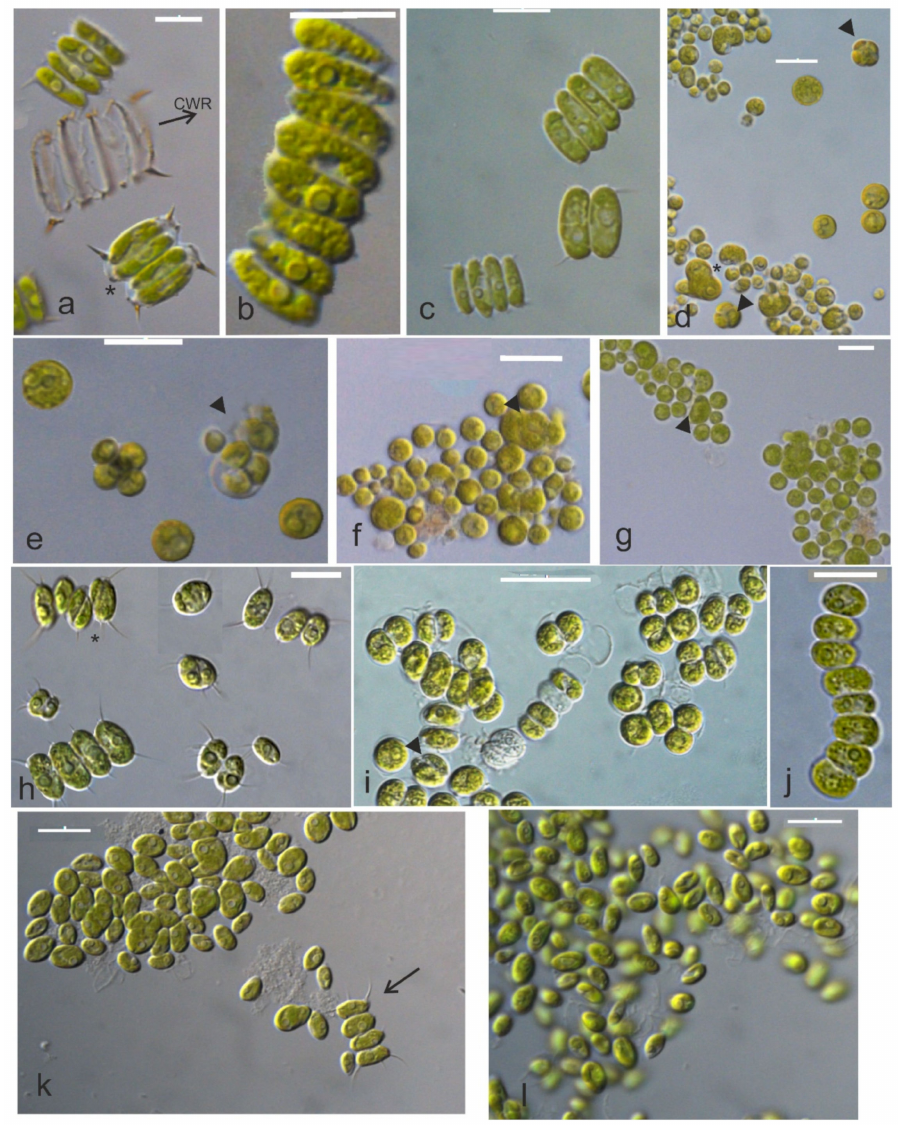
Figure 5. Light micrographs of strains Desmodesmus sp. TAU-MAC 0910 ( a , b ) and 1010 ( c ), Desmod- esmus sp. 1817 ( d ), 2017 ( e , f ) and 2617 ( g ), Desmodesmus subspicatus 0415 ( h ), Desmodesmus multi- variabilis 1917 ( i ) and 2517 ( j ), Desmodesmus abundans 2117 ( k ) and 2717 ( l ); ( a ): a mature four-celled coenobium, cell wall ornaments (observable from cell wall residues, CWR) and a cell division of mother cell into two daughter cells (asterisk). ( b ): an eight-celled coenobium. ( c ): mature two- and four-celled coenobia. ( d ): young and mature cells, autosporangia (arrowheads), and a cell division of the mother cell into two daughter cells (asterisk). ( e , f ): young and mature cells and aplanosporia (arrowhead). ( g ): young and mature solitary cells and aplanosporia (arrowhead). ( h ): coenobia with numerous spines and a cell division of mother cell into two daughter cells (asterisk). ( i ): solitary cells and two-celled coenobia and aplanosporia (arrowhead). ( j ): an eight-celled coenobium. ( k ): mostly solitary cells and four-celled coenobium with spines (arrow). ( l ): solitary cells. All images except ( g ), are with DIC optics. Bars, 10 µ